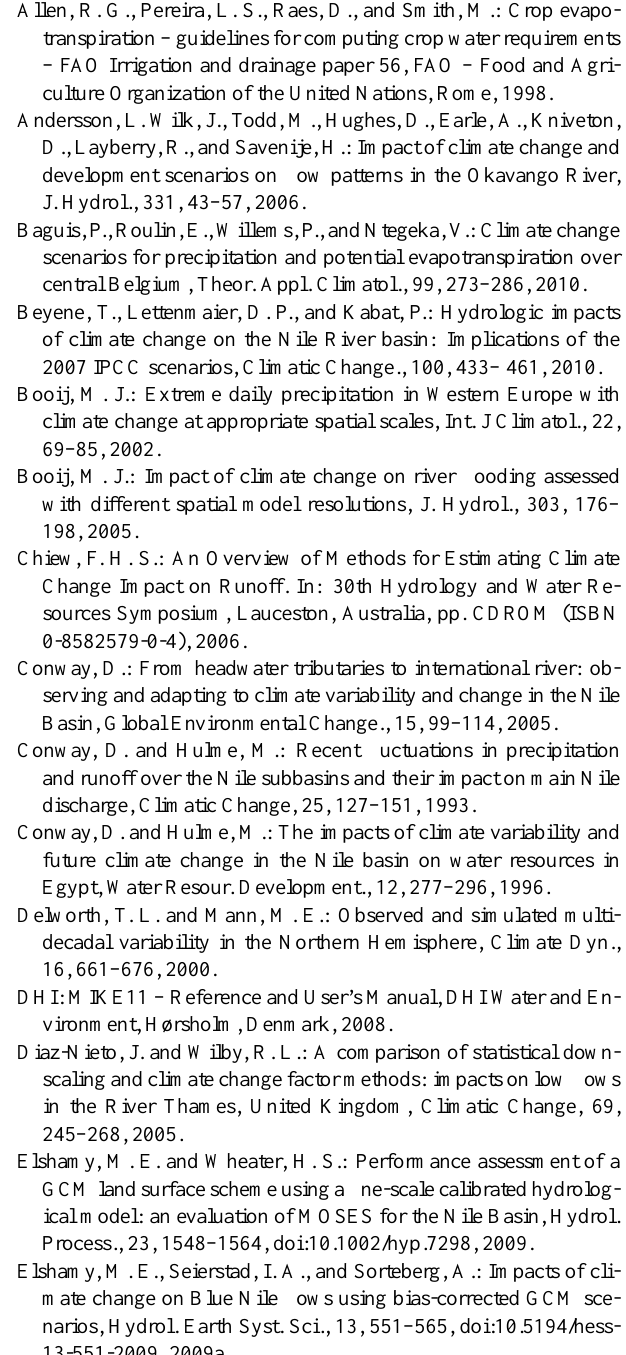
Fig. 11. Regional projected change comparison of mean annual flow volumes between Nyando and Lake Tana catchments for eight GCM runs (VHM